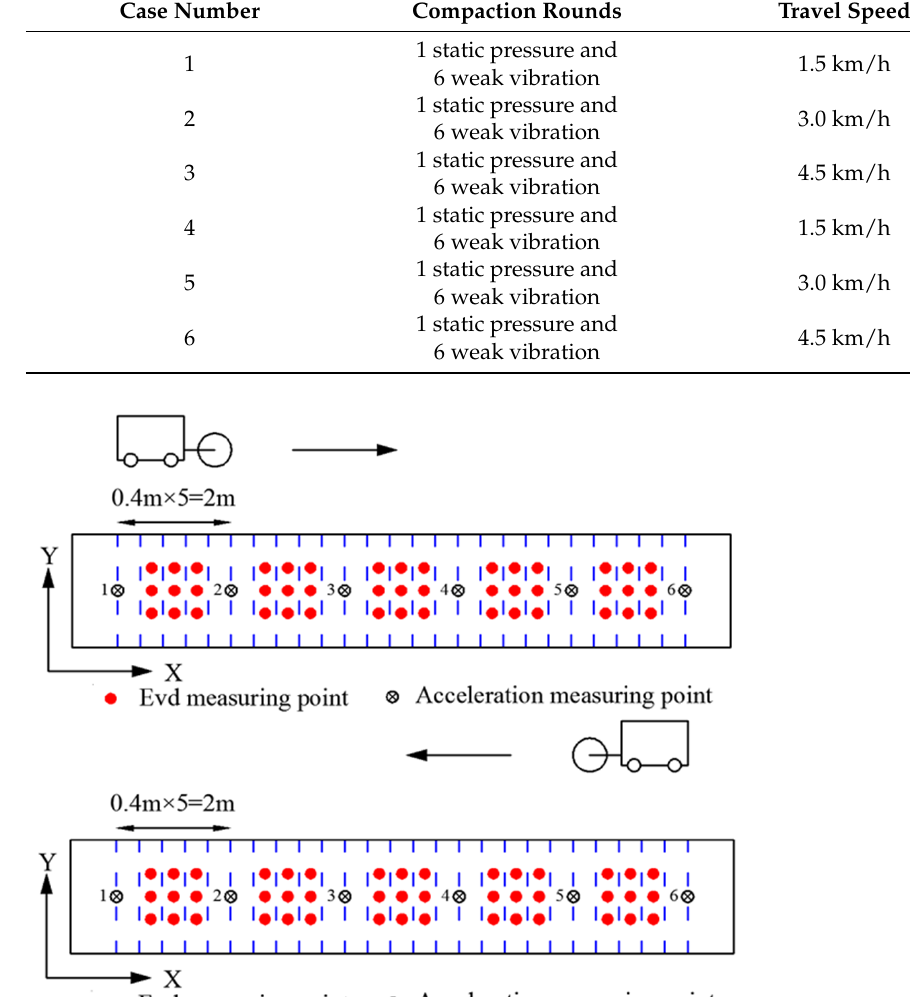
Figure 3. A round compaction